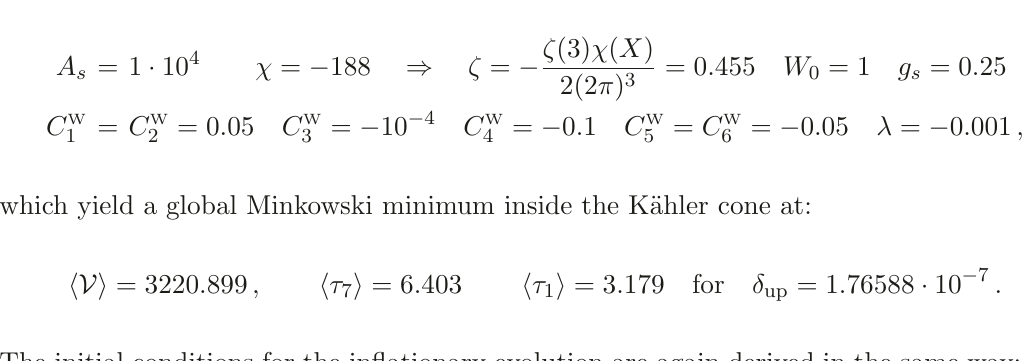
Figure 10 . Evolution of all KK masses (with M (4) and the gravitino mass m